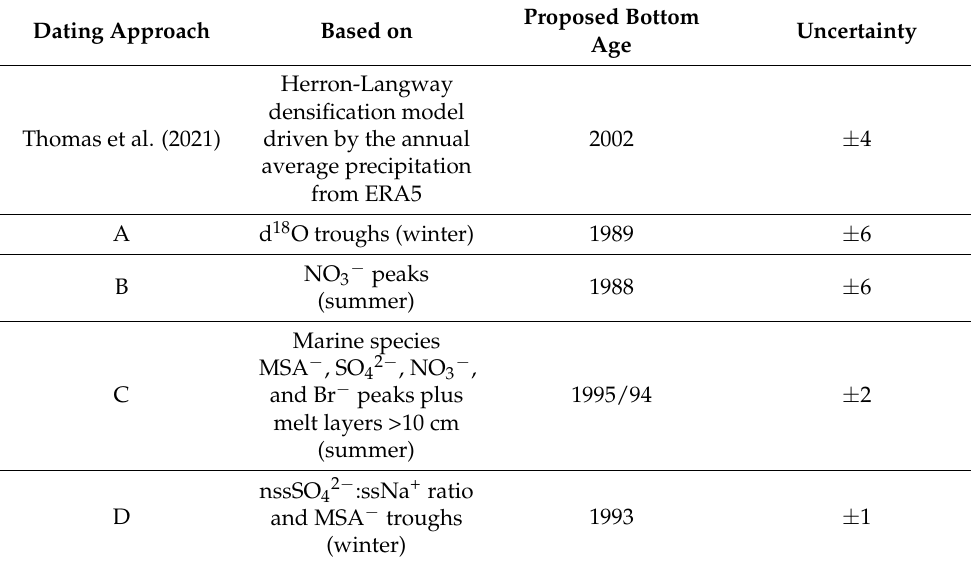
Table 1. Overview of the dating approaches applied in the Young Island ice core, details given in the text (Chapter 3.3.–3.4.).